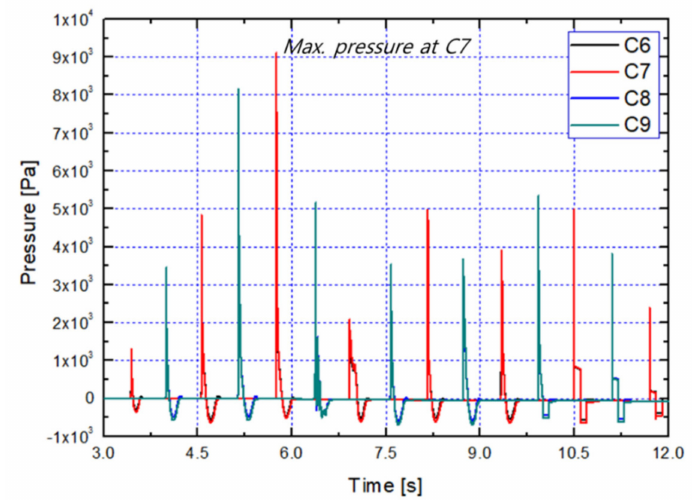
Figure 9. Sloshing pressure history in CFD analysis.